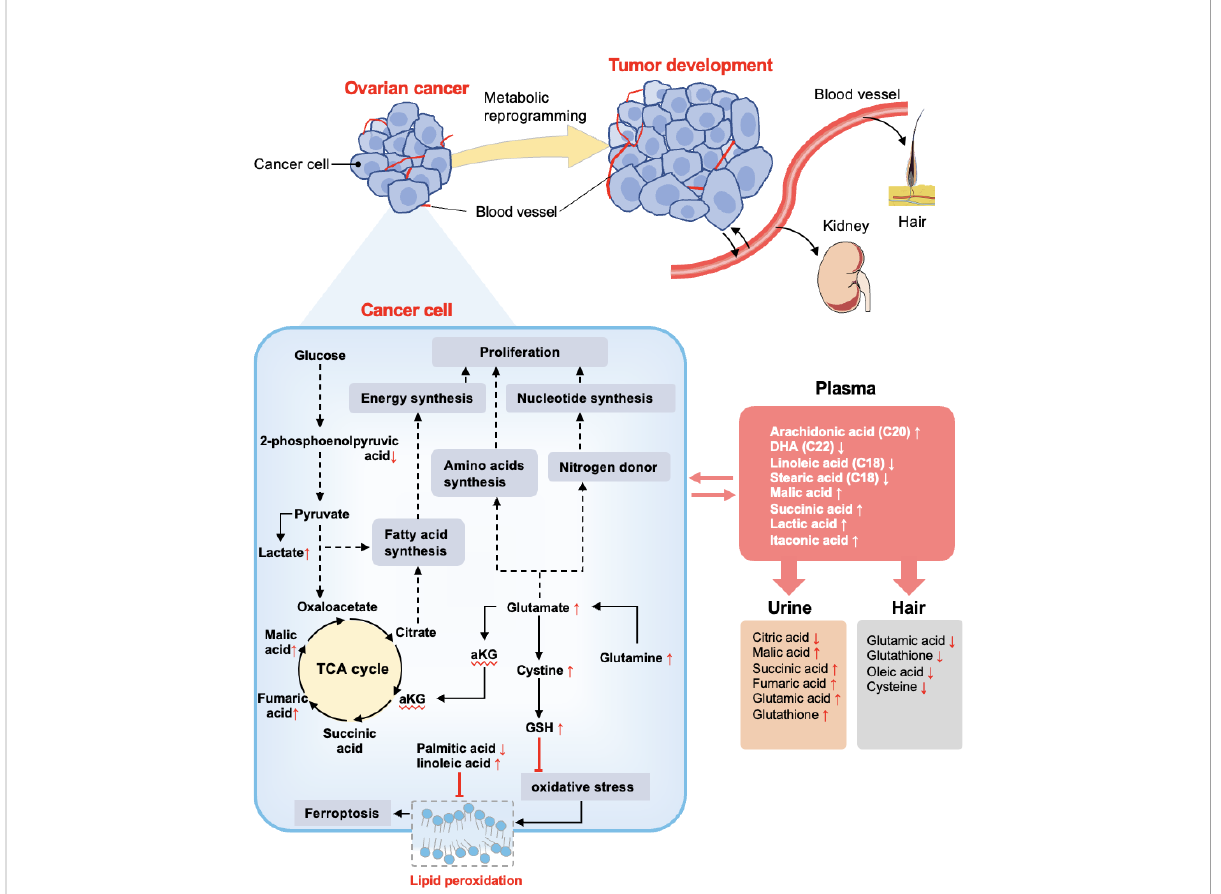
FIGURE 7 Summary of altered metabolites and metabolic pathways in this study. Reprogramming metabolites of ovarian cancer is thought to support the biological processes that enable tumor development. The metabolome of OC patients and non-malignant patients were compared. In cancer cells, glycolysis, TCA cycle, and glutamate metabolism were upregulated to support fatty acids synthesis, amino acids synthesis, and nucleotide synthesis, and fi nally contribute to cell proliferation. GSH was conducive to inhibiting oxidative stress, as well as fatty acids assist with inhibiting lipid peroxidation. Vasculature plays an important role in substance exchange with OC tissue and also translates metabolites to the kidney and hair. The black solid arrows depict the movement of metabolites or metabolic reactions, and dashed arrows depict the positive regulatory effects of metabolic components. The red arrows (following the metabolites) indicate increased or decreased regulation of metabolites in OC groups detected in different samples based on signi fi cant results in Figures 2,